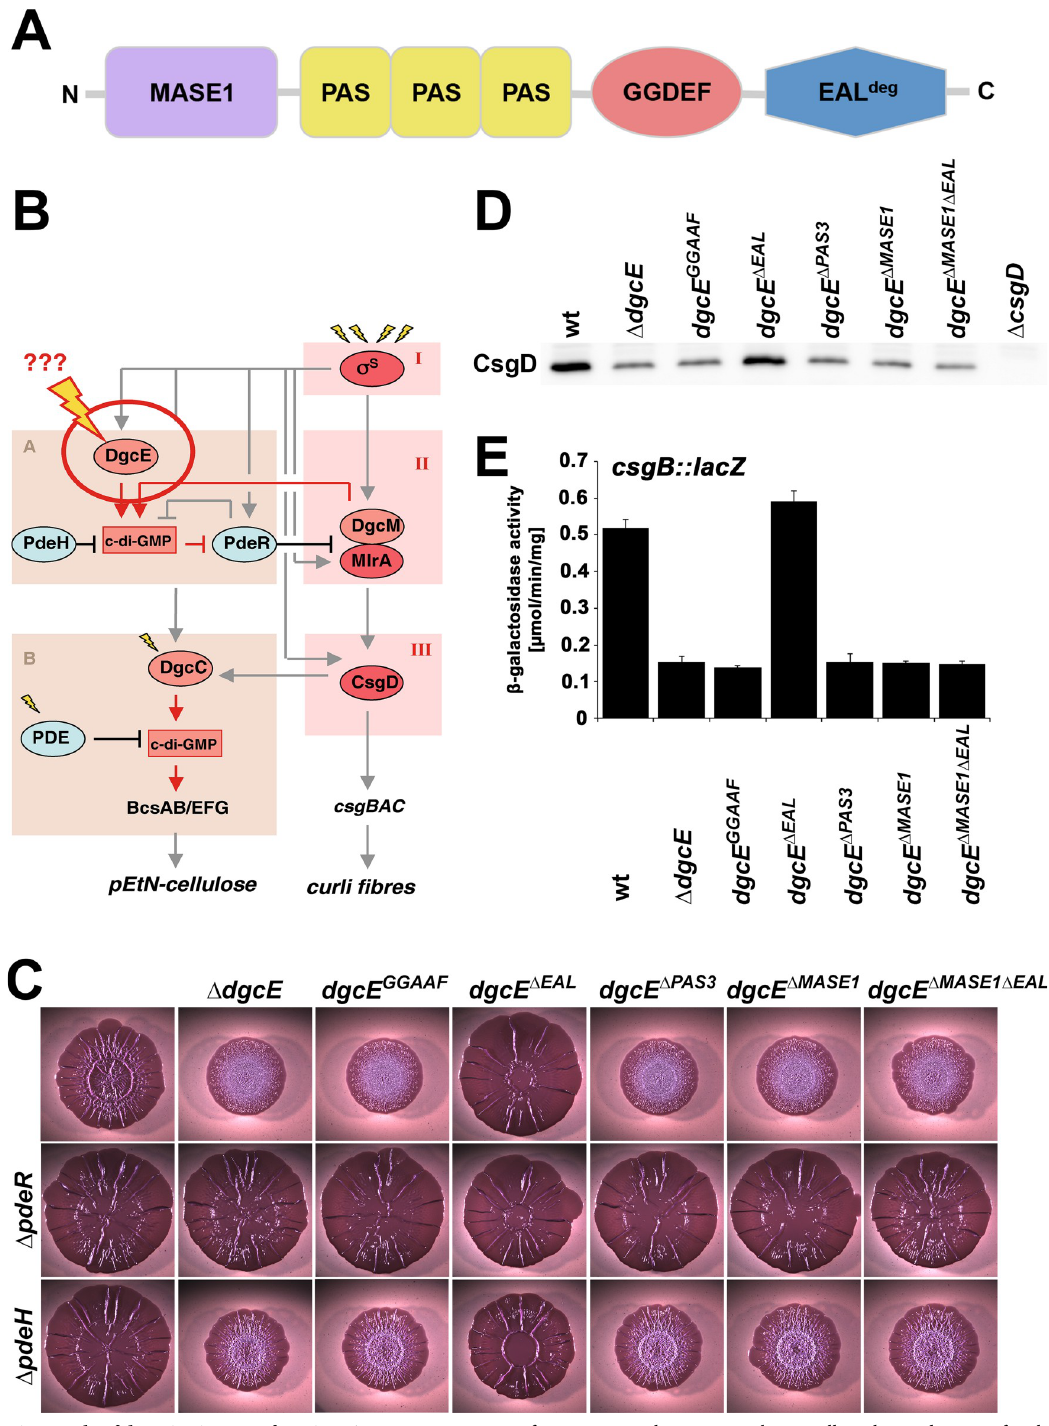
Fig 1. Role of domains in DgcE function. A: Domain structure of DgcE. B: Regulatory network controlling the production of curli fibres and pEtN-cellulose. The vertical ’backbone’ of the network is the transcription factor cascade σ S /MlrA/CsgD (in red), with c- di-GMP input occurring via modules A and B, which include the integrated action of different DGCs and PDEs (in light red and light blue, respectively). DgcE is the master DGC at the top level of this hierarchy, with its signal input and processing (indicated by the bolt) being the central topic of this study. C: Macrocolonies of AR3110 derivatives with the indicated chromosomal dgcE alleles in otherwise wt, Δ pdeH and Δ pdeR backgrounds were grown on Congo red plates for 5 days at 28˚C. D: CsgD levels determined by immunoblot analysis in strain AR3110 carrying the indicated chromosomal dgcE alleles. Samples were obtained at an OD 578 of 3.6–